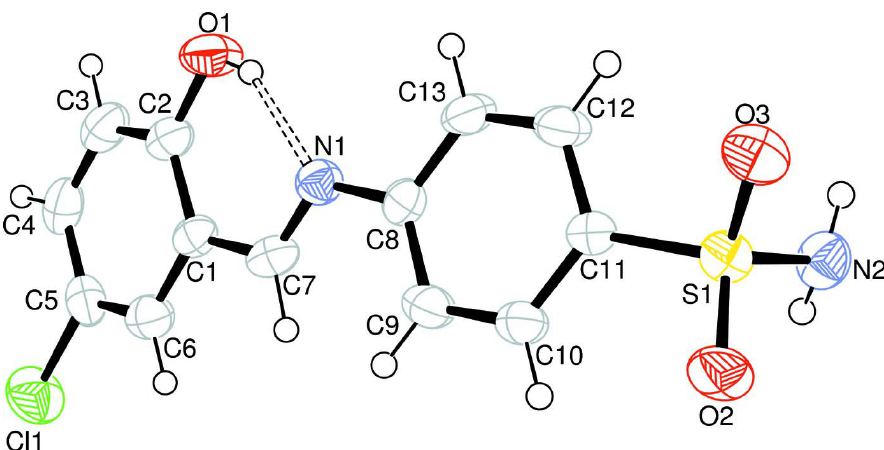
Figure 1 The molecular structure of the title molecule, with the atom-numbering scheme. Displacement ellipsoids are drawn at the 50% probability level. Hydrogen bond is shown as dashed line.